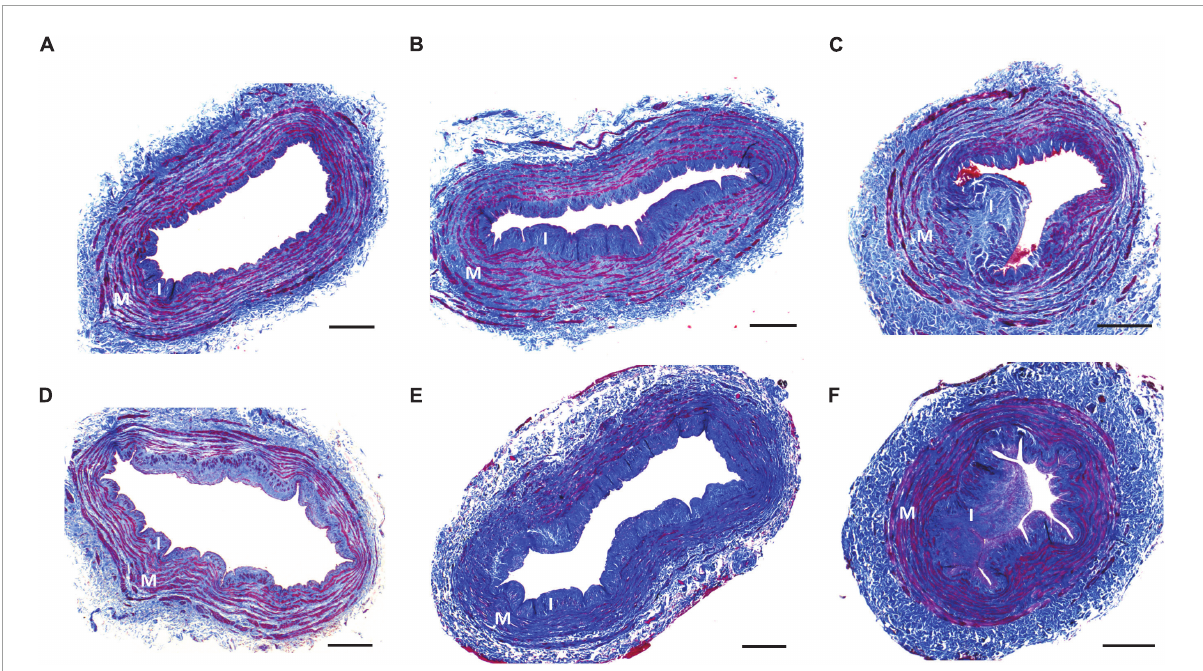
FIGURE3 Representative vein morphometry in CKD/ESKD and non-CKD patients. Representative cross-sections of non-CKD (A–C) and CKD/ESKD veins (D–F) exemplifying mild (A,D) , moderate (B,E) , and high intimal hyperplasia (C,F) . Pictures in (A,D,F) also show cases of low medial fibrosis, whereas (B,C,E) present cross-sections with moderate-high fibrosis. I, intima; M, media. Scale bars = 400 µ